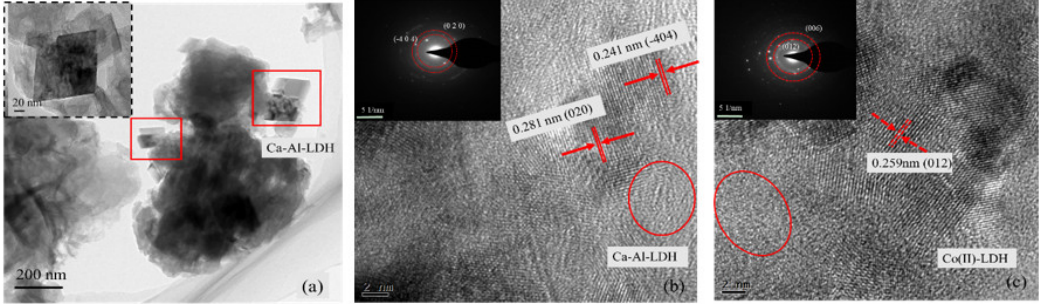
Figure 4. TEM image of CaAl-Cl-LDH ( a ) and HR-TEM images of Ca-Al-Cl-LDH ( b ) and Co-LDH ( c ).